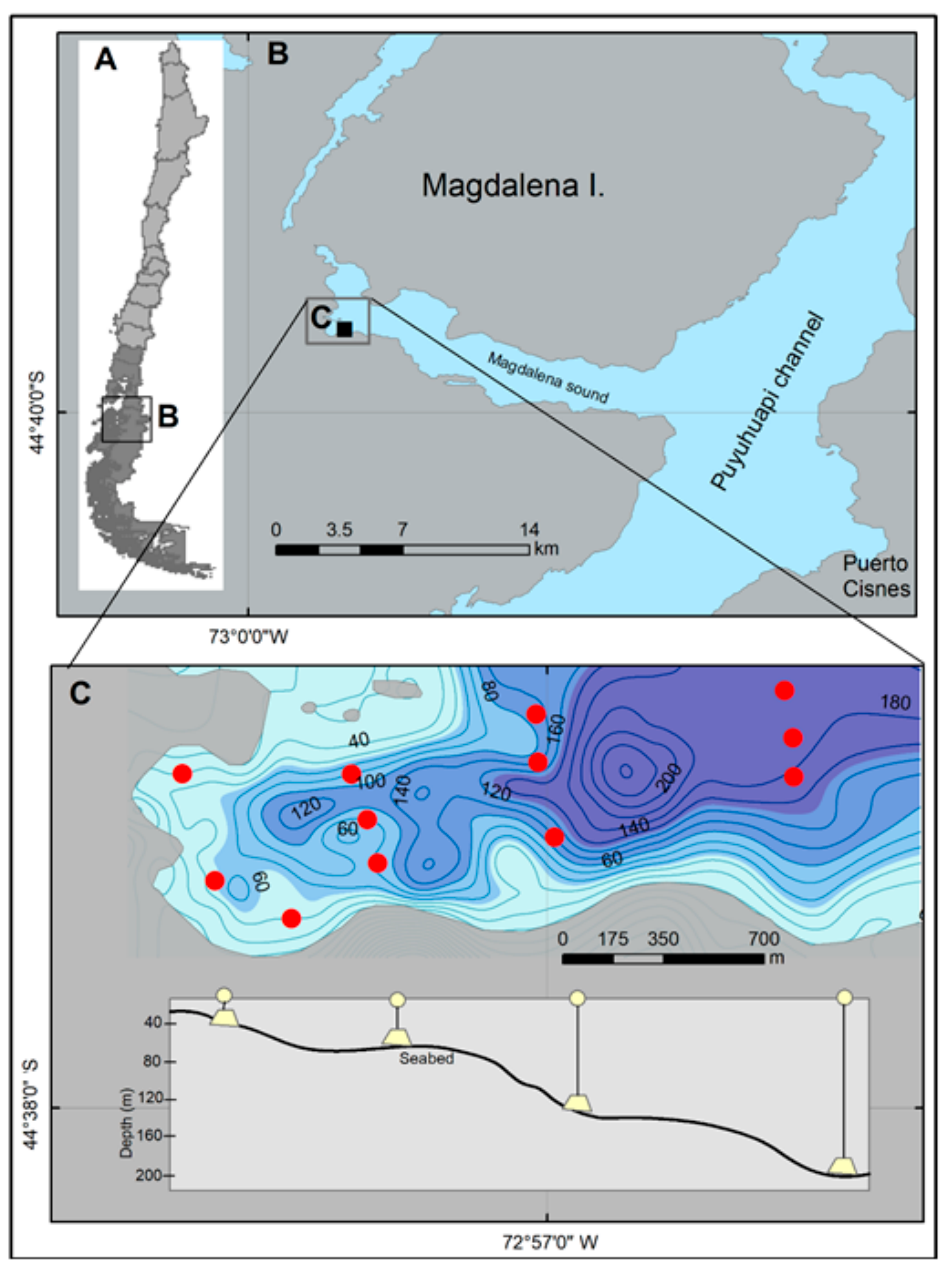
Figure 1. Study area of Magdalena Sound in central Patagonia and schematic represent of bathy- metric positioning of traps. Red circles represent the location of the Traps. (( A ) Map of continental Chilean territory, in ( B ) is the studied zone, and in ( C ) are specified the sampled sites with their respective bathimetry.)